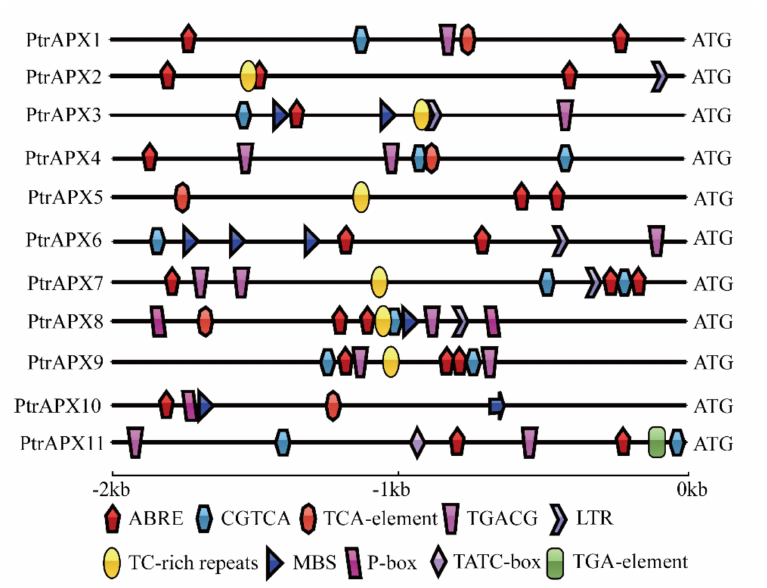
Figure 4. cis -Acting regulatory elements of PtrAPX genes involved in response to phytohormones and abiotic stress. Different cis -elements are indicated by symbols of different